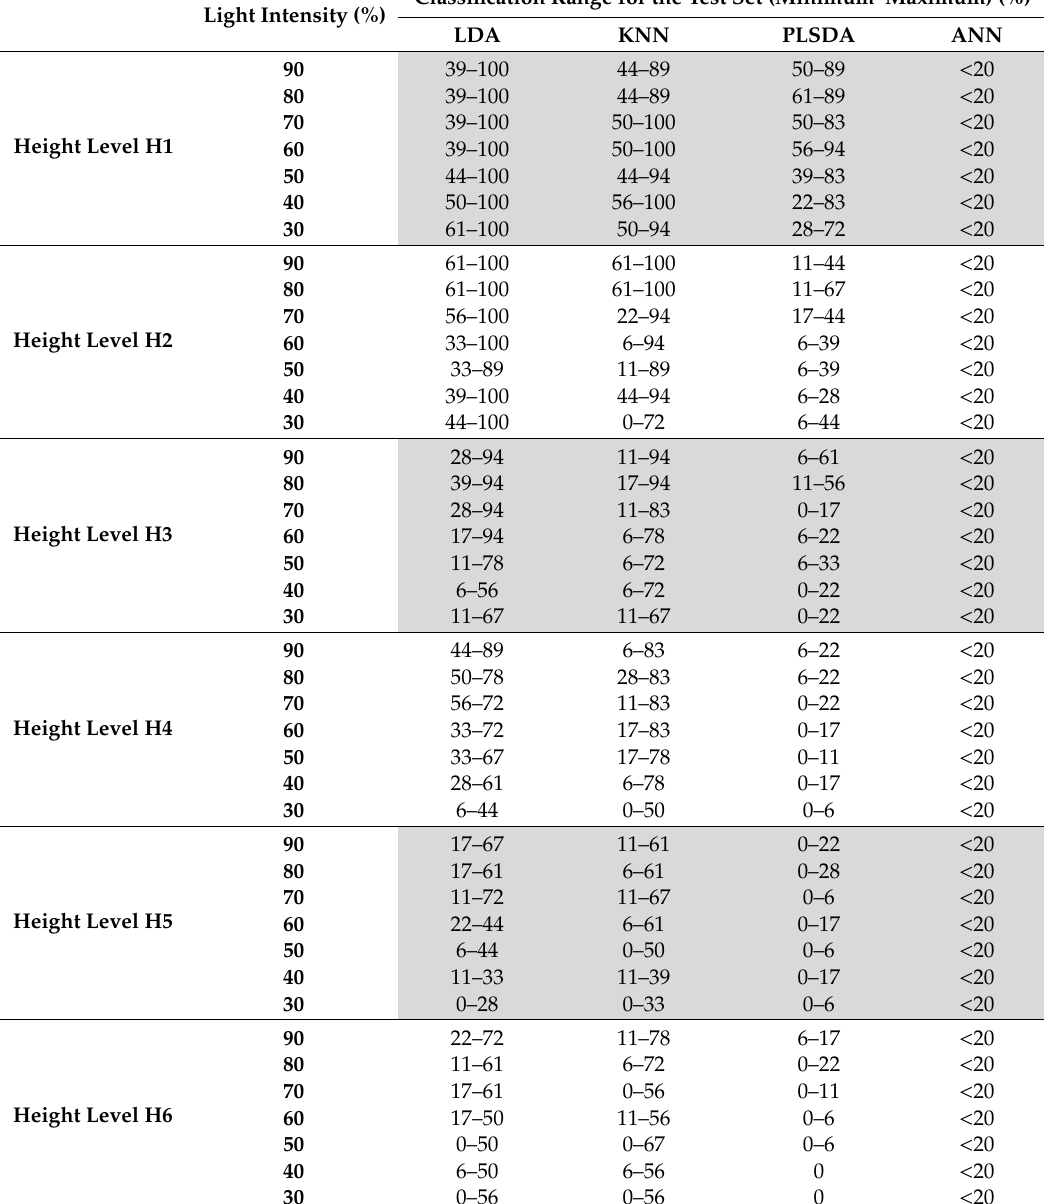
Table 4. Range of classification prediction accuracies for spice samples at di ff erent sensor heights and light intensities using di ff erent methodologies after scanned using an NIR